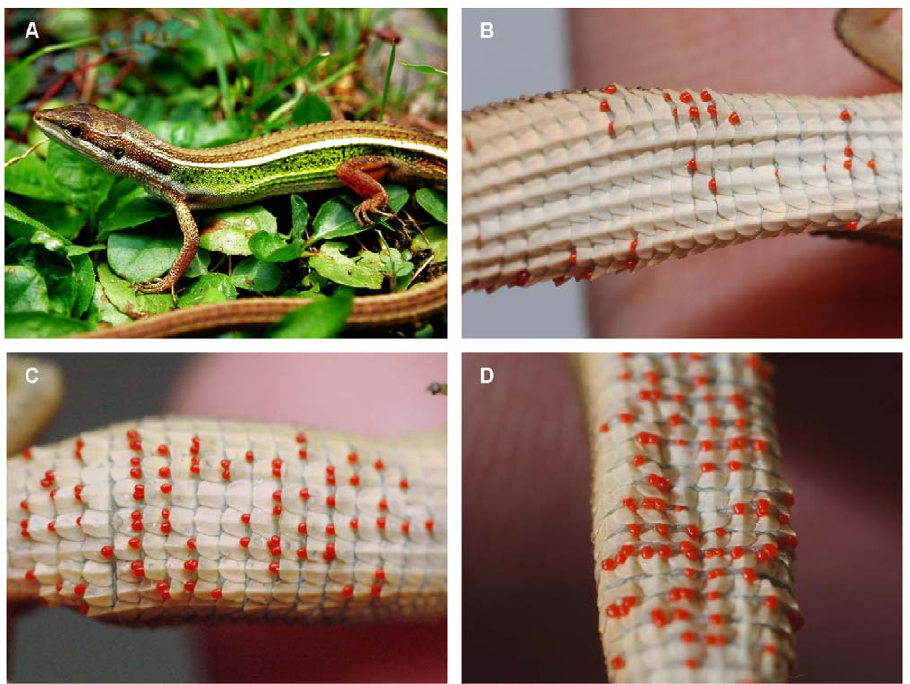
Figure 1. The Takydromus lizard and trombiculid mites. An adult male Takydromus viridipunctatus during the breeding season showing lateral green spots (A), and three different individuals with low (B), median (C) and high (D) infestation by trombiculid mites.